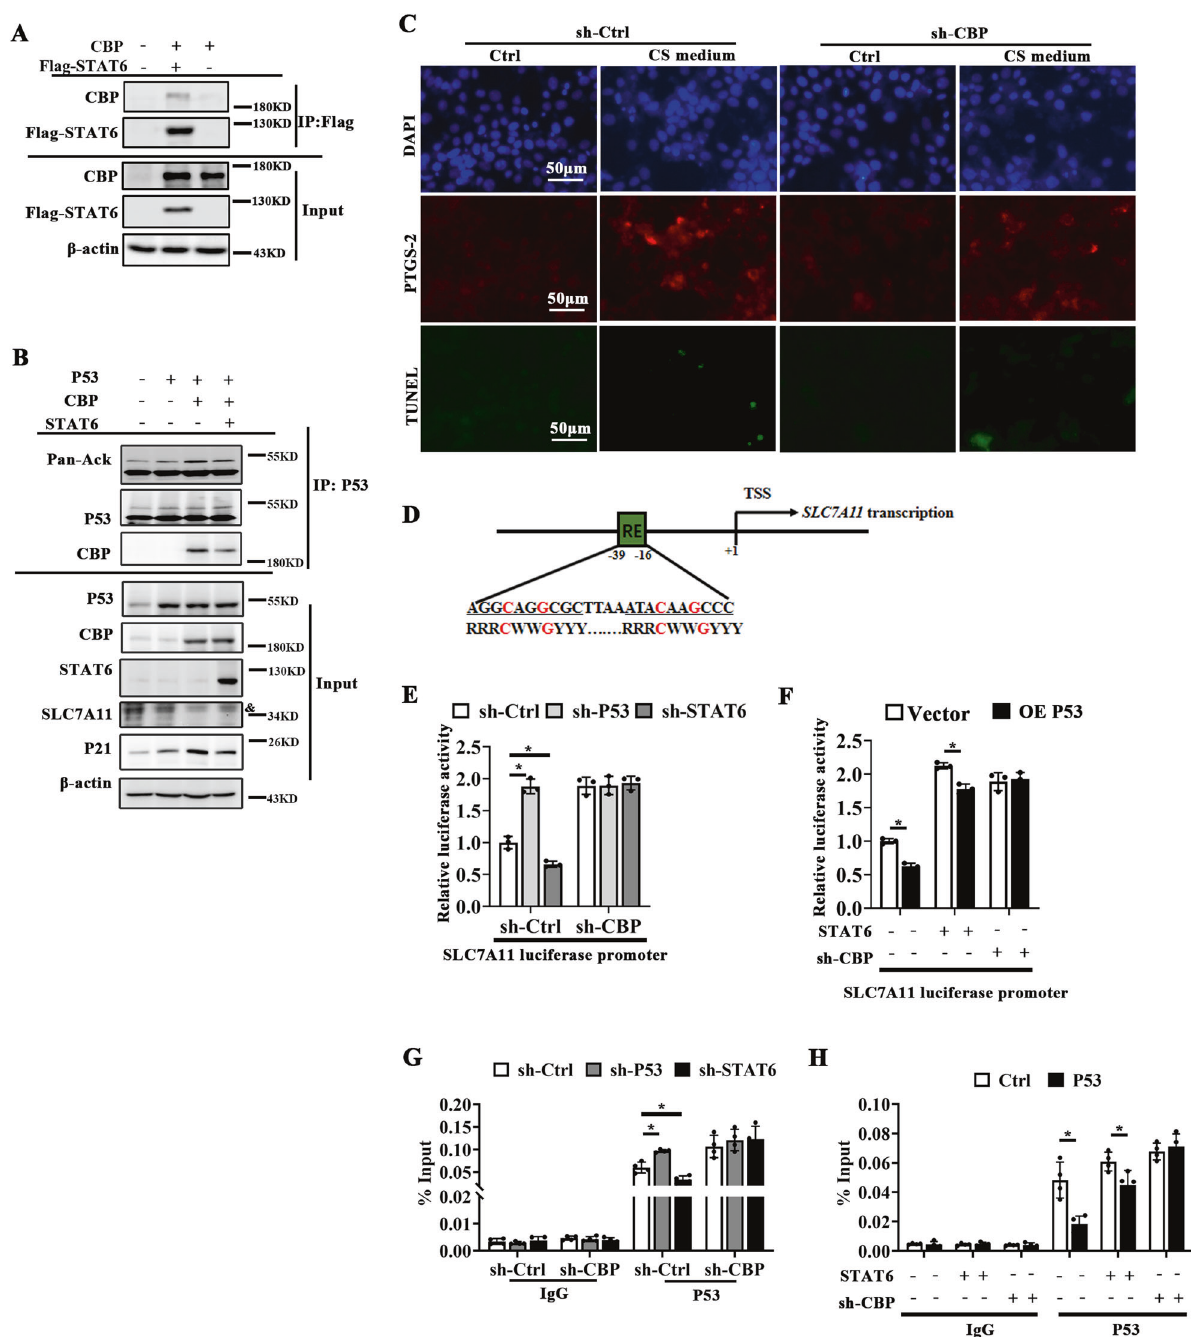
Fig. 6 STAT6 competitively binds with CBP to restore the inhibition of P53 on the expression of SLC7A11. A Cells transfected with difference combination of CBP and Flag-STAT6 were subjected to immunoprecipitation (IP) followed by immunoblot analyses. B HBE cells were co-transfected with different combination of P53, CBP, STAT6 as indicated and subjected to immunoprecipitation (IP) followed by immunoblotting (& means the indicated band). C Cells transfected with sh-Ctrl or sh-CBP were subjected to immuno fl uorescence staining of PTGS-2 and TUNEL assay. Representative images were shown. D Schematic diagram of P53 binding site and sequence on human SLC7A11 gene. (R, A/G; W, A/T; Y, C/T; nucleotides C and G in red are essential for P53 binding). TSS, transcription start site. E HBE cells were transfected with difference combination of sh-CBP, sh-P53, sh-STAT6 accordingly and the luciferase activity of SLC7A11 was detected. Data were presented as means ± SD ( n = 3, * p < 0.05, Ctrl vs. treatments). F The effects of P53 overexpression on the context of STAT6 overexpression or sh-CBP. Luciferase activity of SLC7A11 was determined. The results were presented as means ± SD ( n = 3, * p < 0.05, Vector vs . OE-P53). G , H The regulation of P53 on SLC7A11 promoter was con fi rmed by ChIP assay in HBE cells with indicated treatment. Results were expressed as mean ± SD ( n = 4 * p < 0.05, sh-Ctrl vs . sh-P53/sh-STAT6 or Ctrl vs . P53 overexpression).